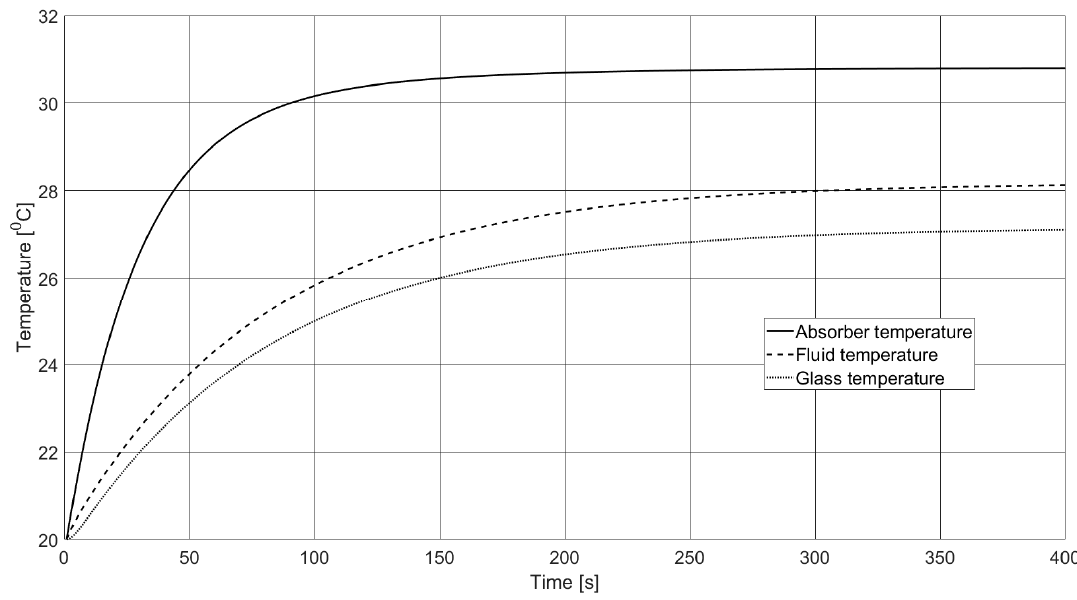
Figure 10. The step response of the collector determined using the ETN method according to Chochowski.